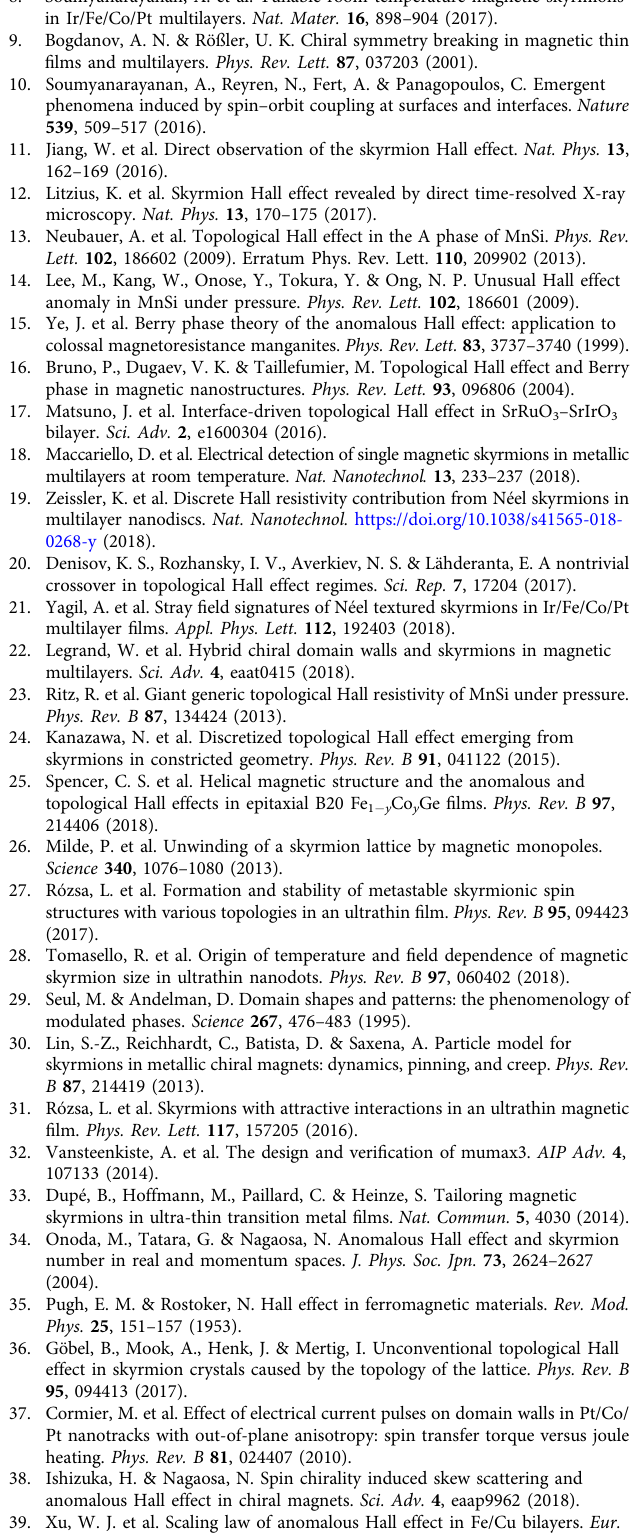
p(cid:3) (cid:4) ffiffiffiffiffiffiffiffiffiffiffiffiffi A = K , where, A eff